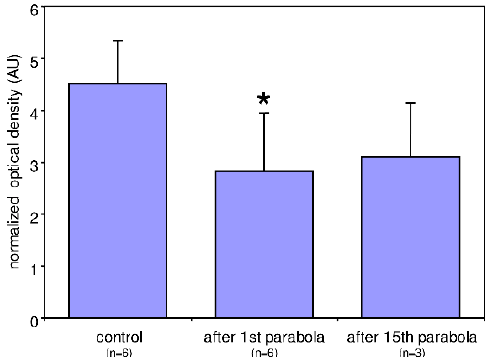
Figure 1. Average optical density of hypoxia-inducible factor (HIF)-1 α -positive bands in Western blots of protein extracts from MDA-MB-468 cells normalized to total protein of the conditions as indicated. Compared to the control conditions (i.e., in 1 g in-flight condition before the first parabola) HIF-1 α expression after the 1st parabola was significantly (* = p < 0.05) about 40% lower and stayed this low until the last (15th) parabola although there was a slight trend to a recovery of the HIF-1 α expression ( p = 0.075 vs. control).